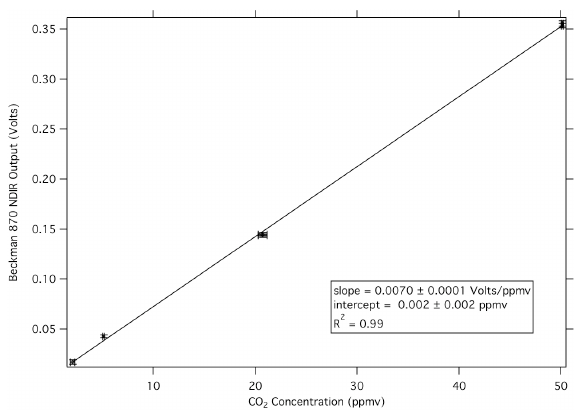
2 Figure 2. Calibration of the Beckman 870 NDIR CO 2 analyzer. Four CO 2 gas standards were 3 used: 2.065 ( ± 0.207) ppmv, 5.12 ( ± 0.10) ppmv, 20.07 ( ± 0.40) ppmv, and 50.1 ( ± 0.5) ppmv. 4 Fig. 2. Calibration of the Beckman 870 NDIR CO 2 ana- lyzer. Four CO 2 gas standards were used: 2.065( ± 0.207)ppmv, 5.12( ± 0.10)ppmv, 20.07( ± 0.40)ppmv, and 50.1( ±